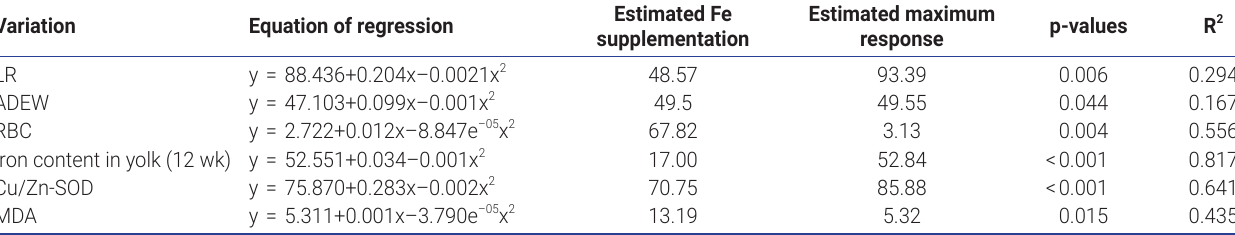
Table 7. Estimated change of the sensitive indices in laying hens with Fe-Lys-Glu supplementation Variation Equation of regression